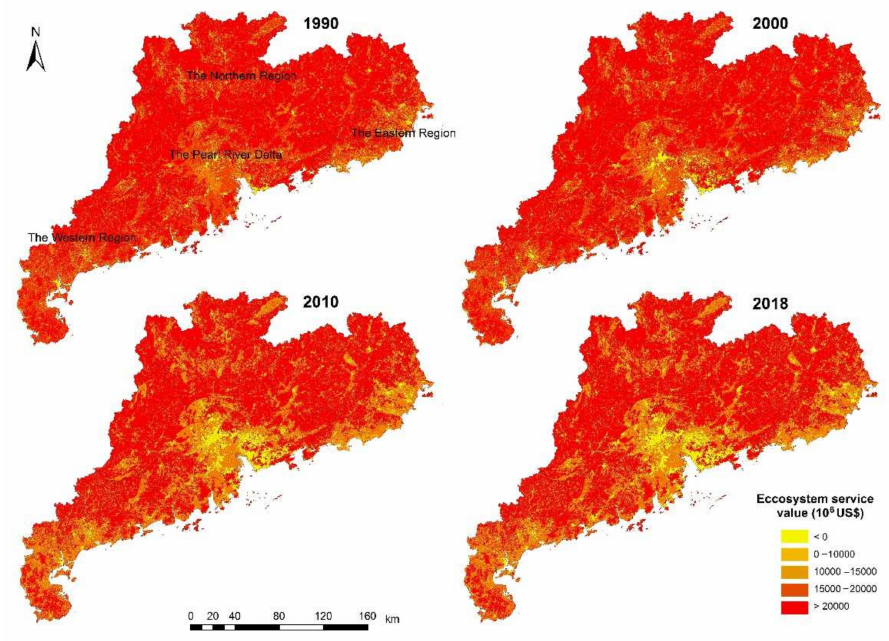
Figure 3. Maps of the total ecosystem service value in Guangdong province from 1990 to